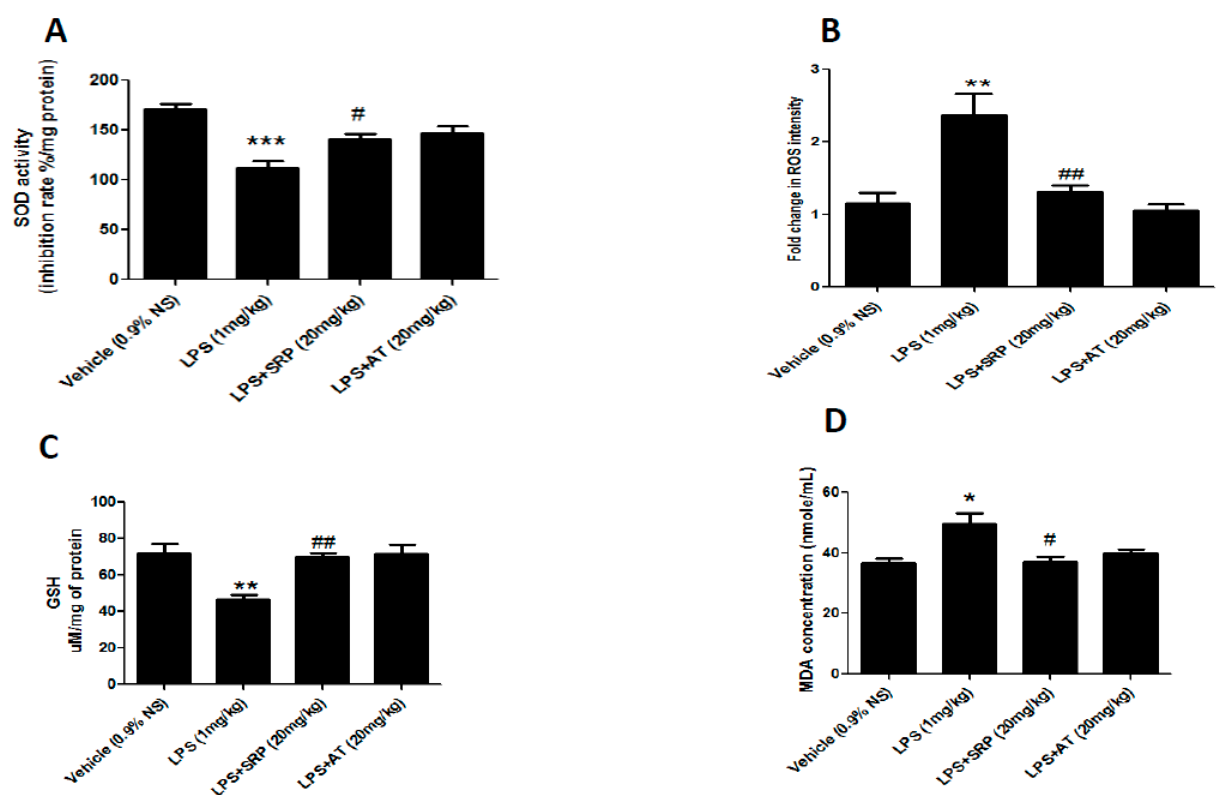
Figure 1. The effect of SRP on oxidative stress biomarkers. Column figure shows the oxidative stress biomarkers measured in aortic homogenates of vehicle control (0.9% NS), LPS-, LPS+SRP-, and LPS+AT-treated animals. ( A ) Superoxide Dismutase; ( B ) reactive oxygen species intensity; ( C ) glutathione activity; ( D ) malondialdehyde (MDA) represent mean ± SEM. n = 6 for each group. * represents significant values when compared to controls at p < 0.05, # represents significant values when compared to LPS-treated animals at p < 0.05, *** represents significant values when compared to control group at p < 0.05, ** represents significant values when compared to control group p < 0.05, ## represents significant values when compared to LPS-treated group at p < 0.05.